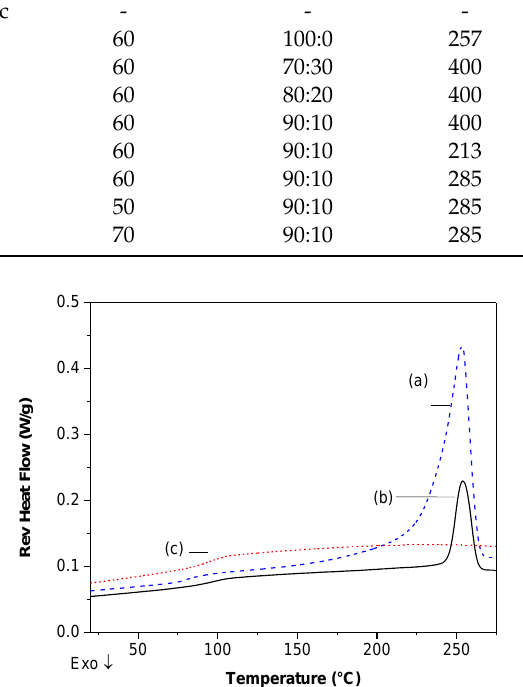
Table 4. Results by DSC for PET fabrics modified obtained by the direct gamma irradiation method.